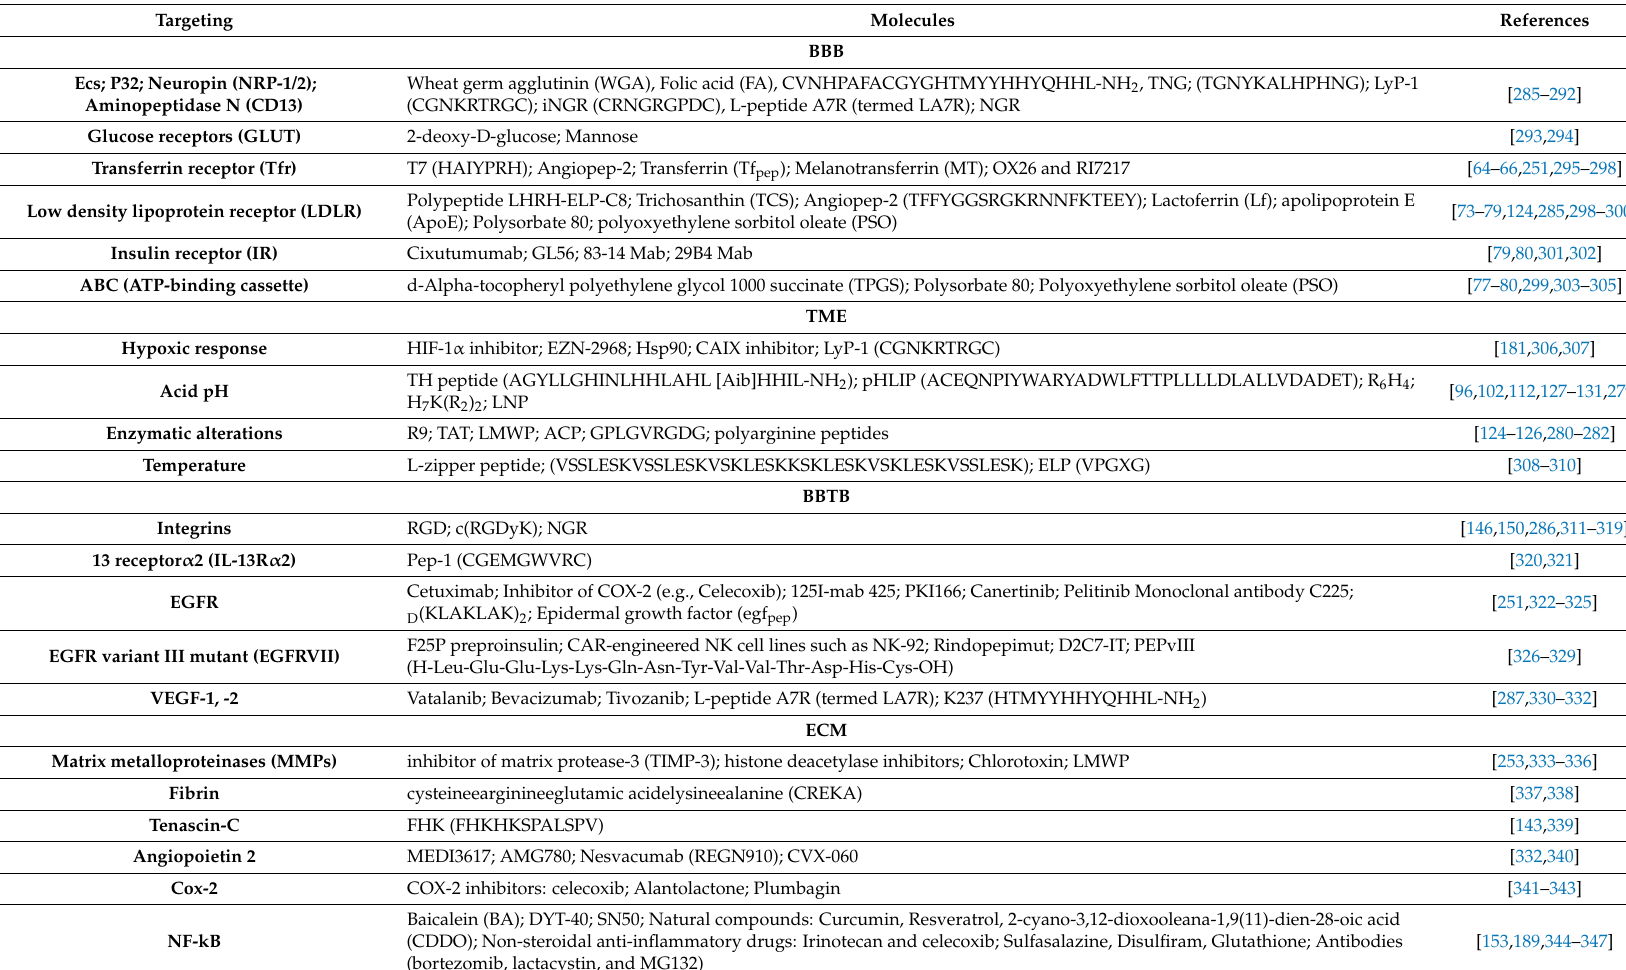
Table 5. List of actively targeted nanoparticles (NPs) to surface cell markers, signaling pathways and tumor microenvironment directed essentially at GB treatment.